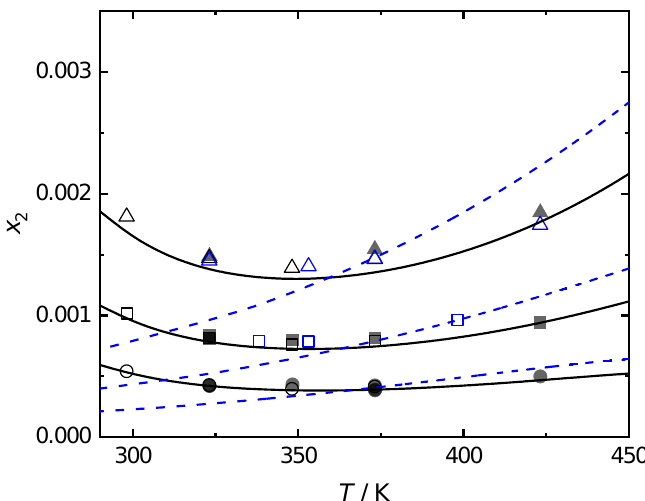
Figure 5. Solubility data of nitrogen in the aqueous phase as a function of temperature for the (H 2 O(1) + N 2 (2)) system at pressures of • , 5 MPa; (cid:4) , 10 MPa; (cid:78) , 20 MPa. The filled symbols denote data from this work, and empty symbols represent data from the literature: black, Wiebe et al. [15]; blue, Saddington and Krase [25]. The continuous lines represent the description of the γ - ϕ model, and dashed lines represent the description of the SAFT- γ Mie model.